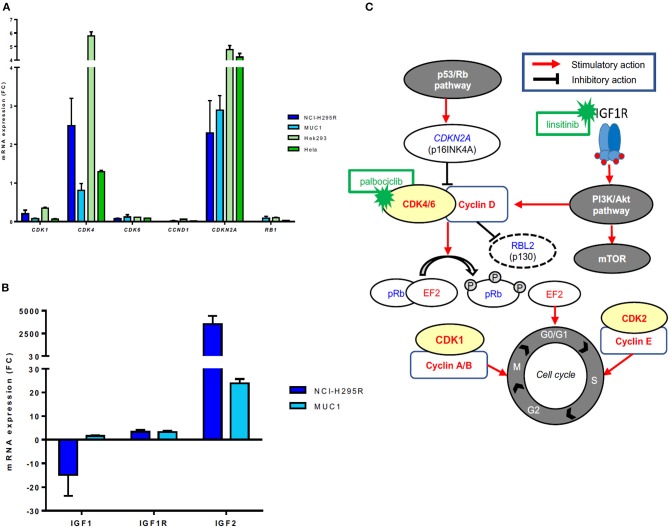
Gene expression of CDK4-related factors in different adrenocortical carcinoma (ACC) cell lines. (A) mRNA expression levels of CDK1, CDK4, CDK6, CCND1, CDK2NA, and RB1 in ACC cell lines NCI-H295R and MUC1 cells (triplicates by RT-qPCR). Hek293 and Hela cells were used as positive controls and β-actin was used as housekeeping gene as internal standard. (B) Schematic representation of the cyclin-dependent kinases/cyclin complexes, their regulation by mitogenic signals and their role in regulating the cell cycle progression as well as corresponding available inhibitors. Activating factors are represented in red, suppressor factors in blue. (C) mRNA expression levels of IGF1, IGF1R, and IGF2 in ACC cell lines NCI-H295R and MUC1 cells (triplicates by RT-qPCR). β-actin was used as housekeeping gene as internal standard.